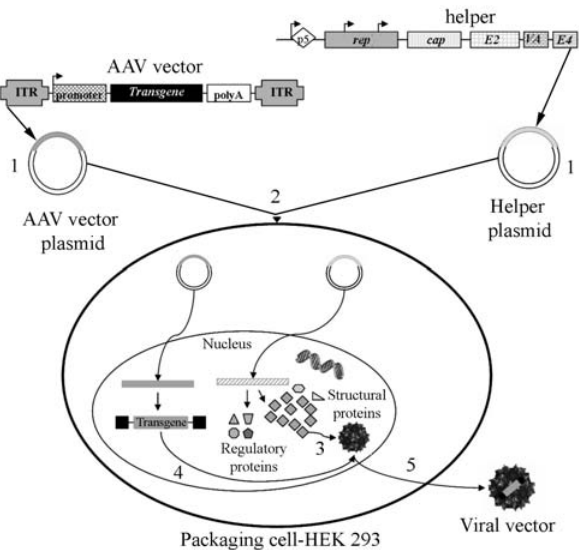
Figure 2 - AAV recombinant vector production. Insertion of the AAV vector and helper cassettes into the respective plasmids (1); co-trans- fection of both plasmids in HEK 293 packaging cells, whose genome con- tains the Ad E1 gene, which together with the other Ad required genes, supplied by the helper plasmid, allows the establishment of a productive infection (2); empty capsid is formed by AAV structural proteins assem- bly into the nucleolus (3); the replicated ssDNA viral genome with the transgene flanked by ITRs (vector plasmid) are packaged into the empty capsid in the nucleoplasm (4), giving rise to a non-replicative recombinant AAV vector virion (5). The regulatory proteins act especially in the repli- cation and packaging